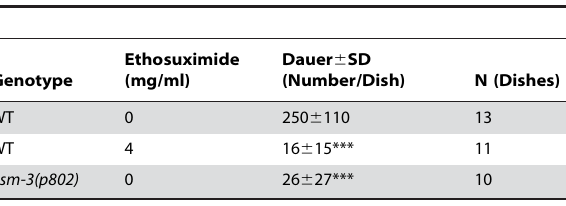
Table 3. Ethosuximide inhibited dauer formation in a high- density, starved population at 25 u C.